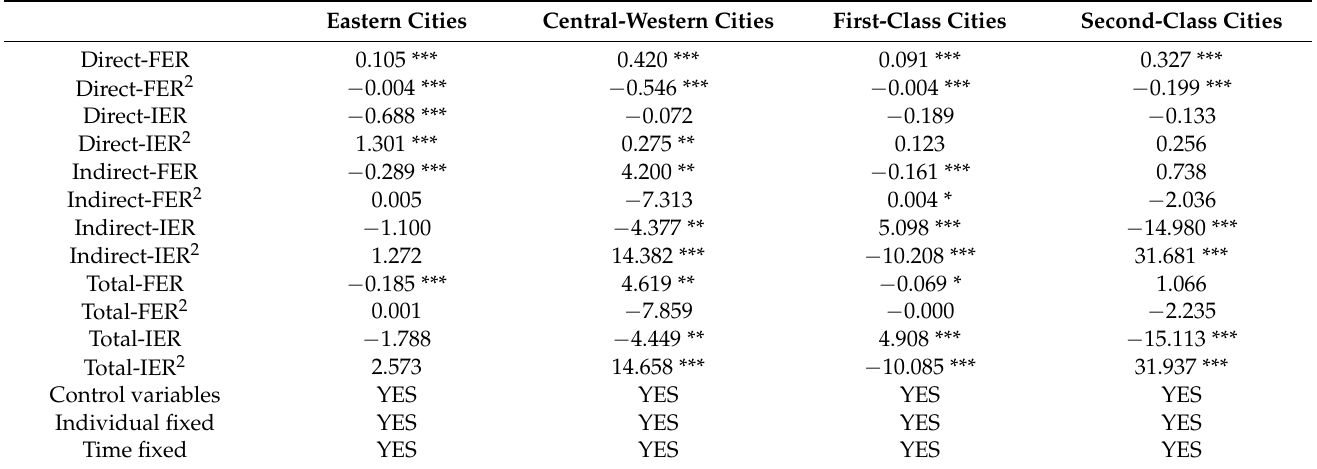
Table 7. Analysis of spatial